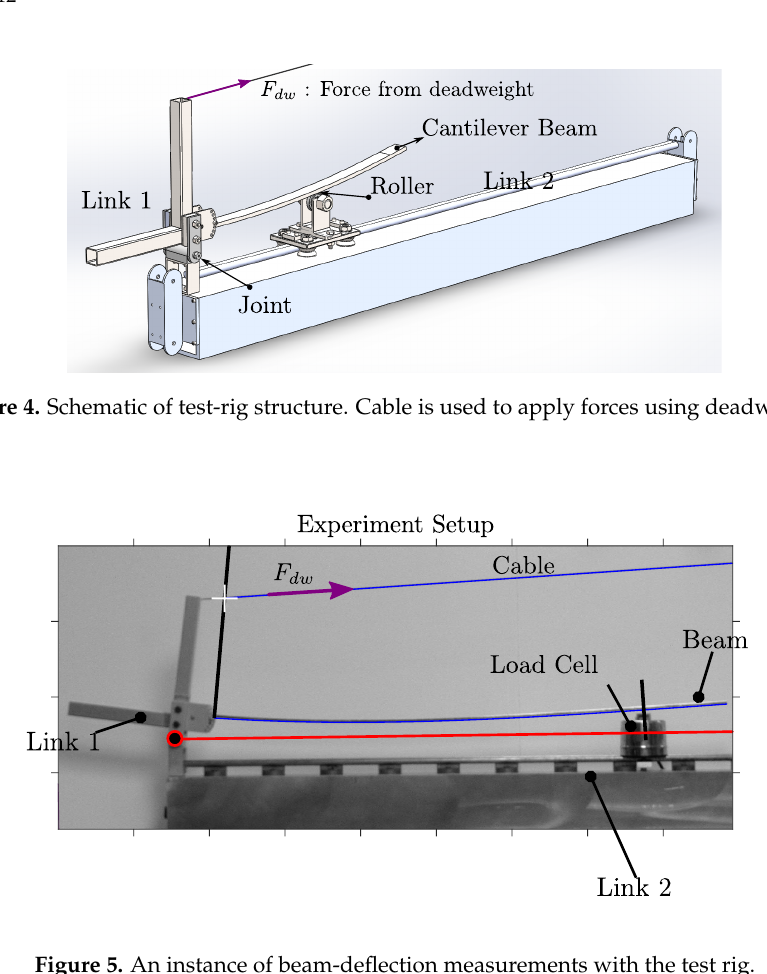
Figure 5. An instance of beam-deflection measurements with the test rig.